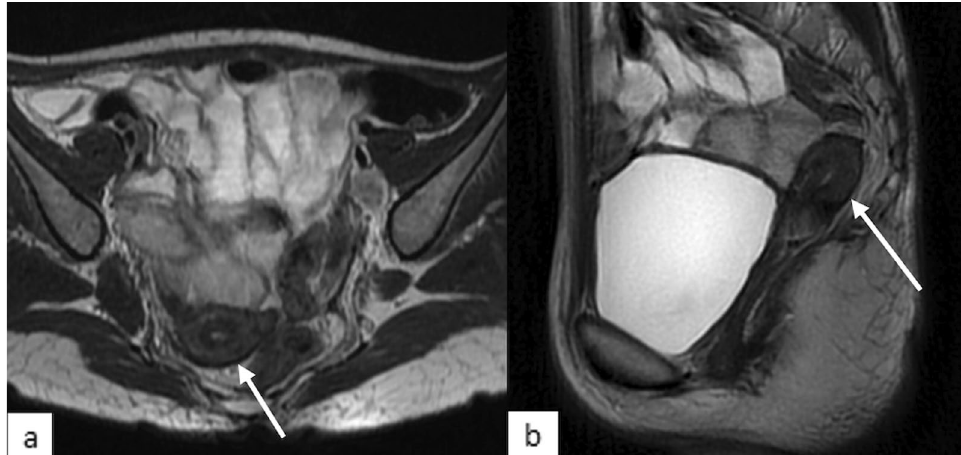
Fig. 2 a , b A 16-year-old female presenting with primary amenorrhoea ( a ) and ( b ) Axial and sagittal T2 WI showing normal positioned hypoplastic uterus with three layered zonal differentiation (straight